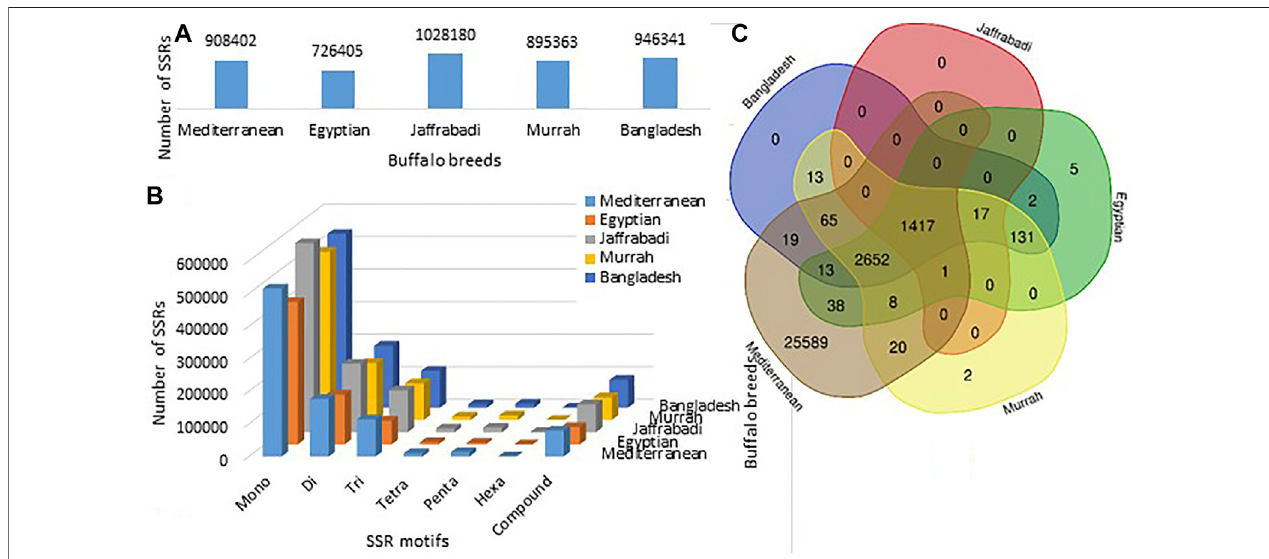
FIGURE3|(A) Breed-wisefrequenciesofSSRs. (B) Breed-wiserepresentationofdifferentrepeatmotifs. (C) CommonanduniquegeneswithabundanceofSSRs in the fi ve breeds of buffalo.